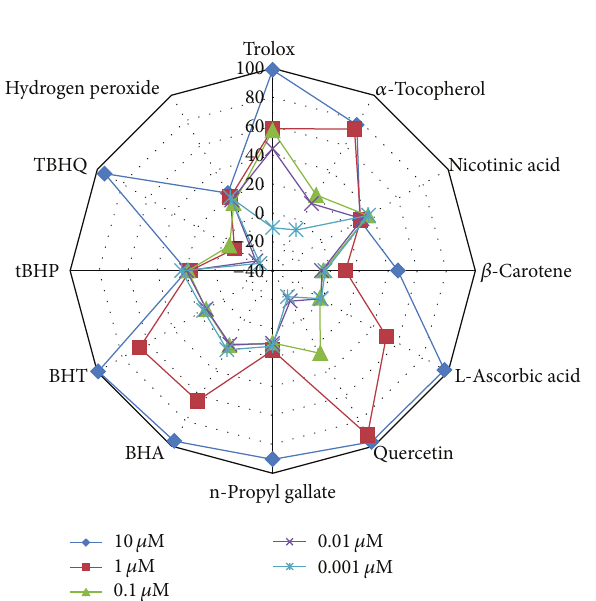
Figure 7: Percent mean values with respect to control. Mean values represent the average values (OD) generated during the time specified.